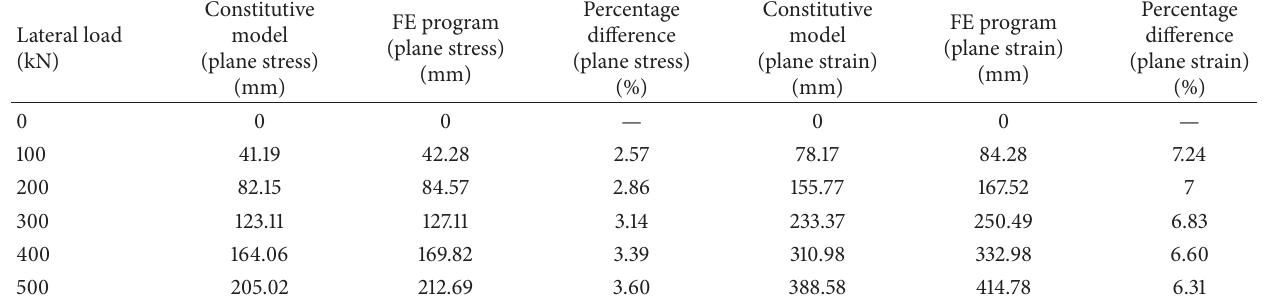
Table 5: Comparison of constitutive model and FE model for displacement of RC3SS at node 1.